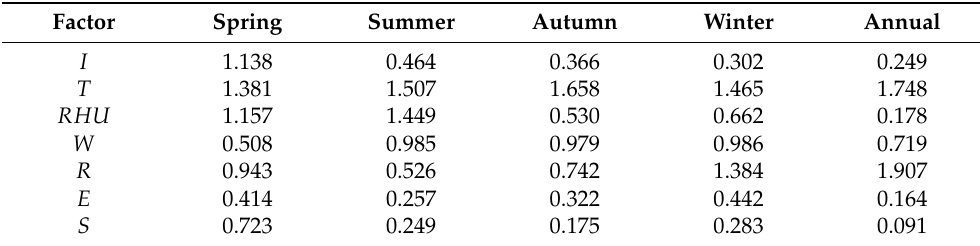
Table 2. VIP scores of different factors for the PM 2.5 concentration estimation. Factor Spring Summer Autumn